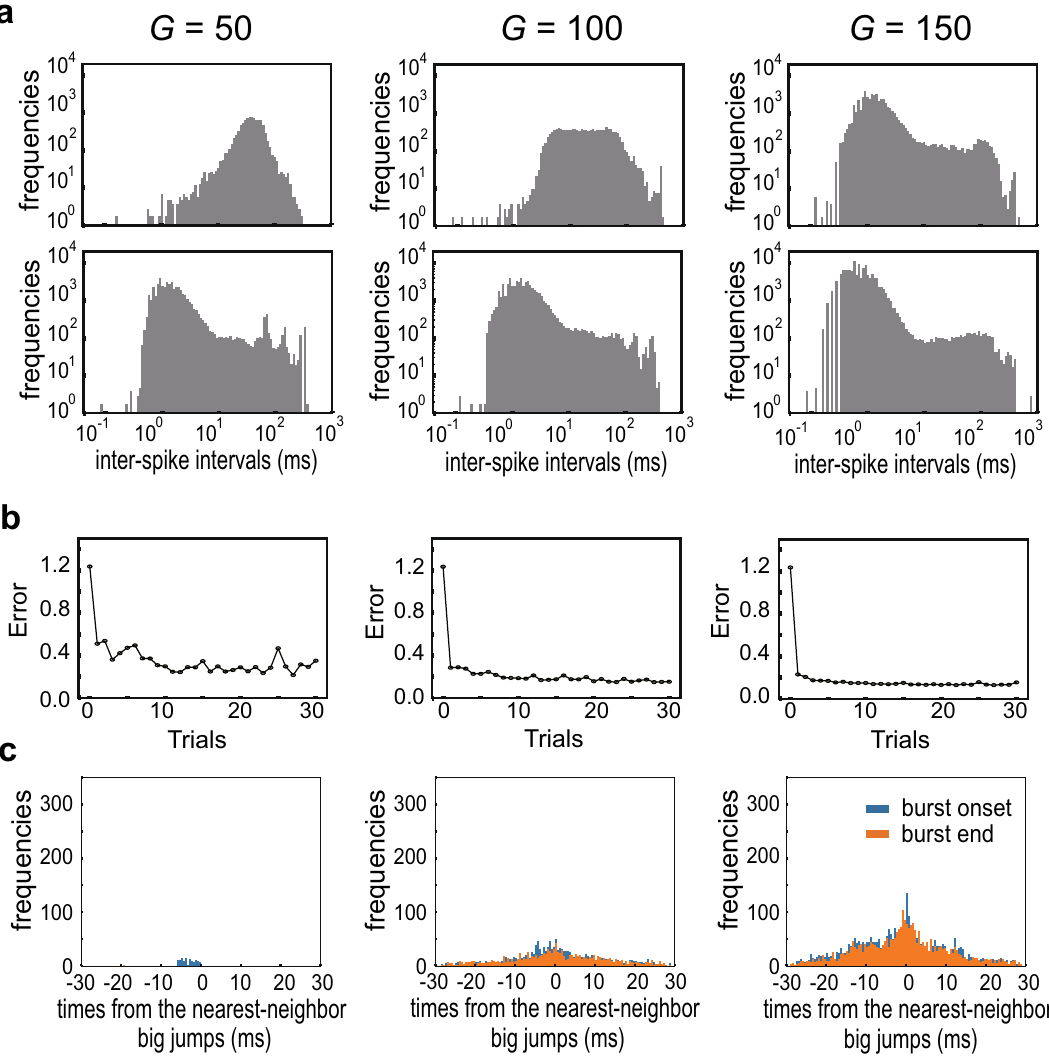
Figure 4. Development of bursting states in the RS mode. The inter-spike interval distributions ( a ), learning curves ( b ) and distributions of burst timing ( c ) were calculated in the network models of RS-type neurons for three different values of coupling